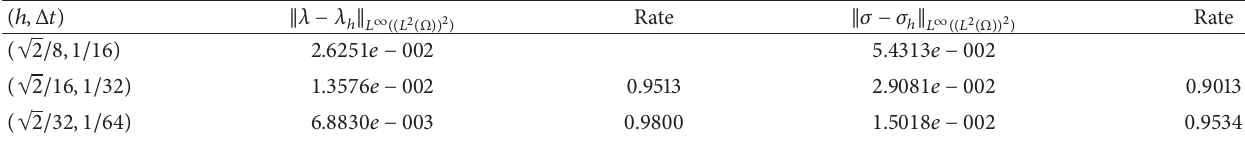
Table 2: The errors and convergence rate for 𝜆 and 𝜎 .